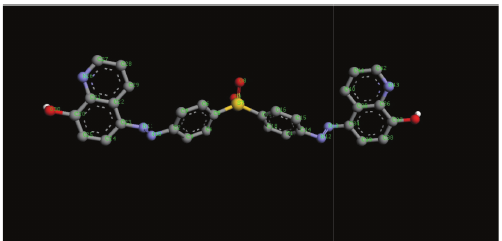
Figure 1: Optimised geometry of ligand (LH 2 ).